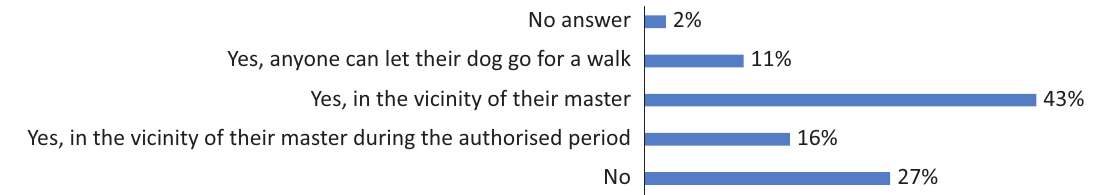
Figure 4. Possible answers to the sentence: “In the forest that I frequent, people can allow their dogs to walk around